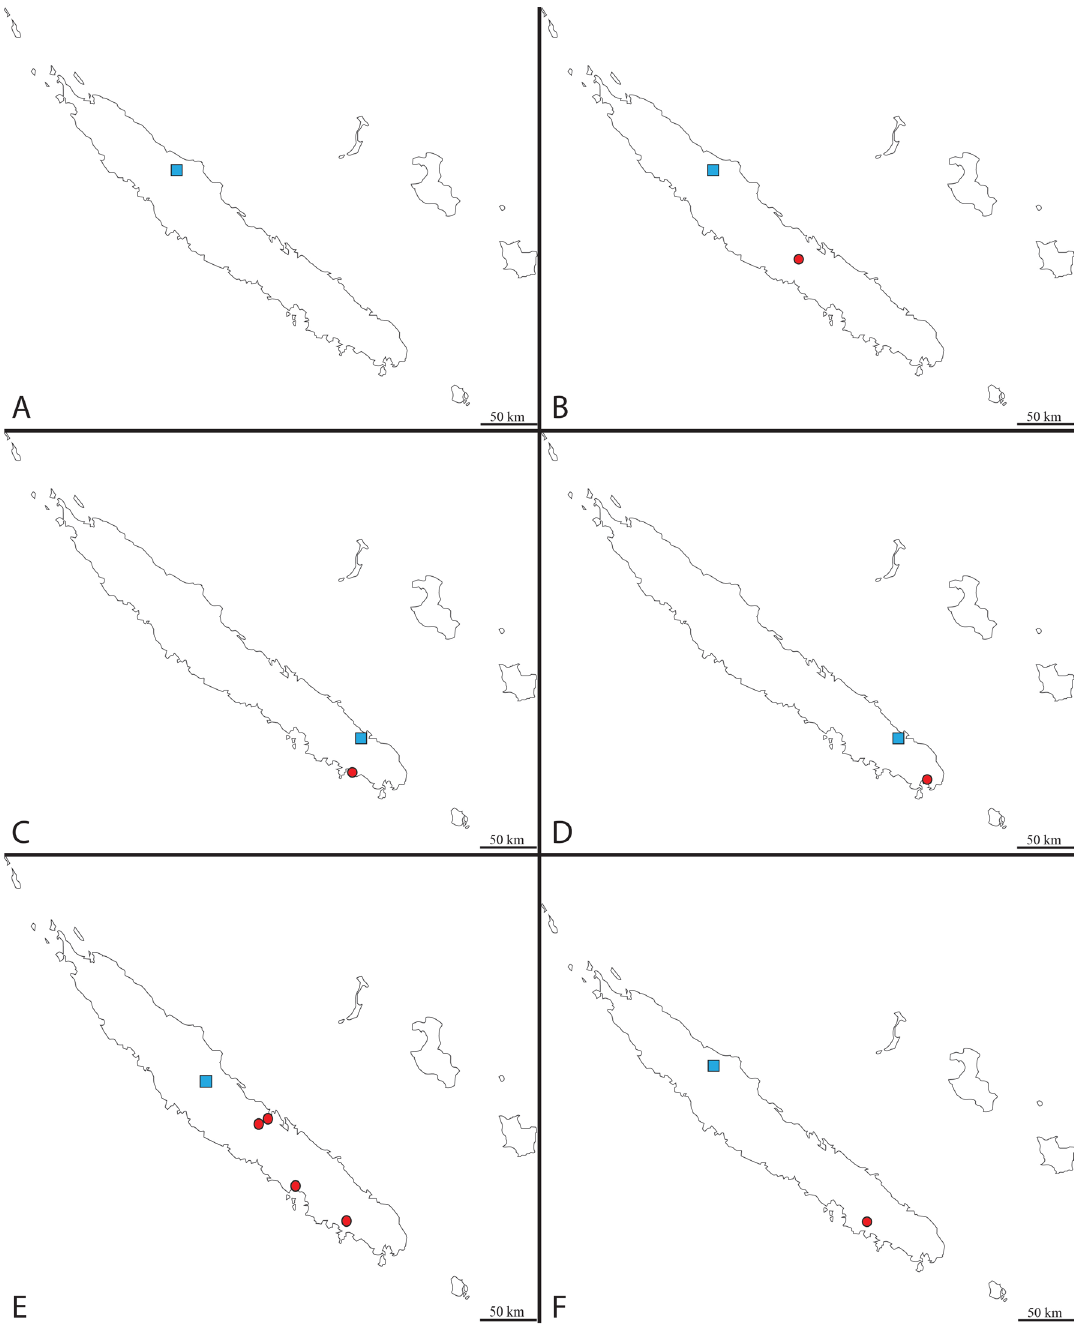
Fig. 12. A . Distribution of Aulacus pascali sp. nov., Pristaulacus elveni sp. nov. and Pristaulacus villemantae sp. nov. B . Distribution of Aulacus burwelli Jennings, Austin & Stevens, 2004; red circle = type locality; blue circle = specimens concerned by this study. C . Distribution of Gasteruption jenningsi sp. nov.; red circle = type locality; blue circle = specimens concerned by this study. D . Distribution of Gasteruption maquis Jennings, Krogmann & Parslow, 2015; red circle = type locality; blue circle = specimens concerned by this study. E . Distribution of Pseudofoenus caledonicus Jennings & Austin, 2005; red circles = localities previously published; blue square = specimens concerned by this study. F . Distribution of Parastephanus mouensis Aguiar, 2005; red circle = type locality; blue circle = specimens concerned by this